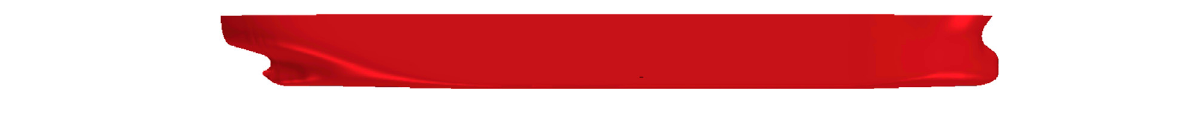
FIGURE 2 | Geometric ship model.